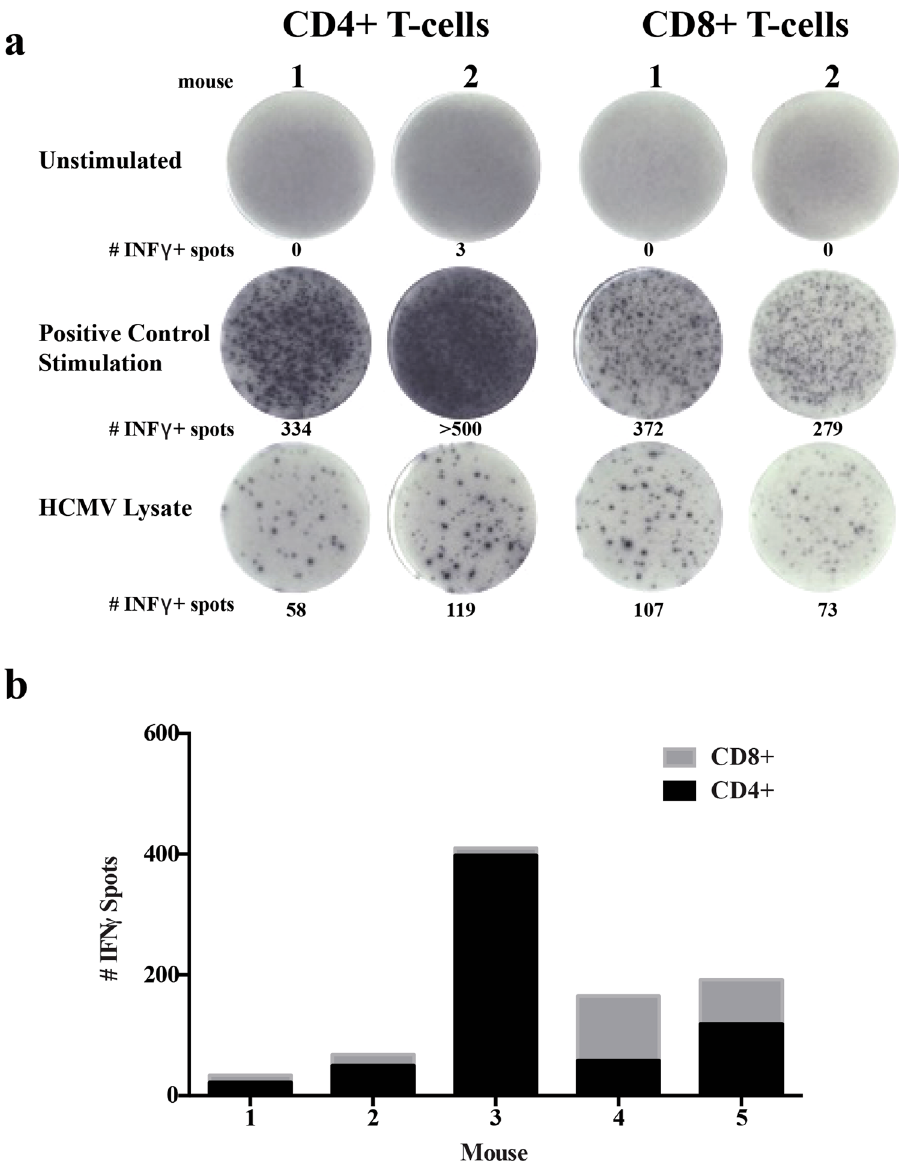
Figure 4. huBLT generate HCMV-specific human INF γ CD4 + and CD8 + T-cell responses. ( a ) huBLT mice were euthanized at 6 weeks post-infection and splenocytes harvested. Total splenic mononuclear cells were isolated using Ficoll and human CD4 + cells separated using magnetic bead isolation (Miltenyi Biotech) (panel 1). Human CD8 + cells (panel 2) were further isolated from the CD4- fraction also using magnetic bead isolation (Miltenyi Biotech) and cultured without stimulation (unstimulated), with positive control stimulation (SEB) or with HCMV lysate on human IFN γ ELISpot plates (MabTech) prior to detection, two independent mice are shown. ( b ) Quantification of the number of IFN γ positive spots produced by the CD4 + and CD8 + fractions from five independent